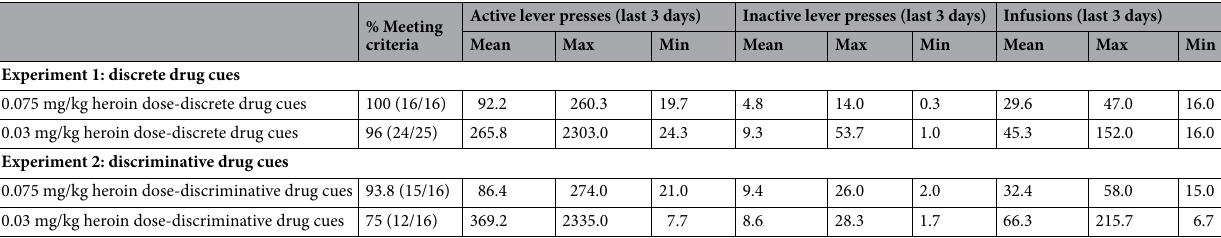
Table 1. Descriptive statistics for animals that met criteria of two-fold more lever pressing on the active versus inactive lever.